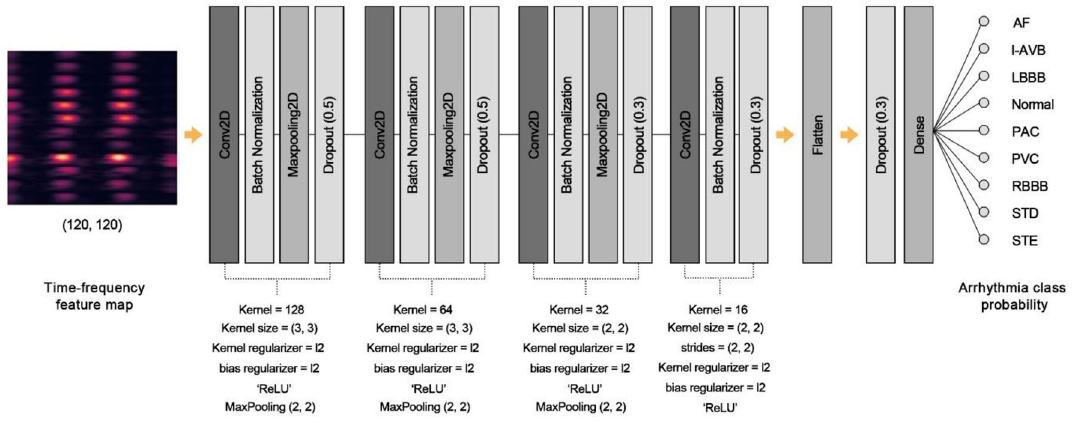
Figure 5. The structure of the 2D CNN